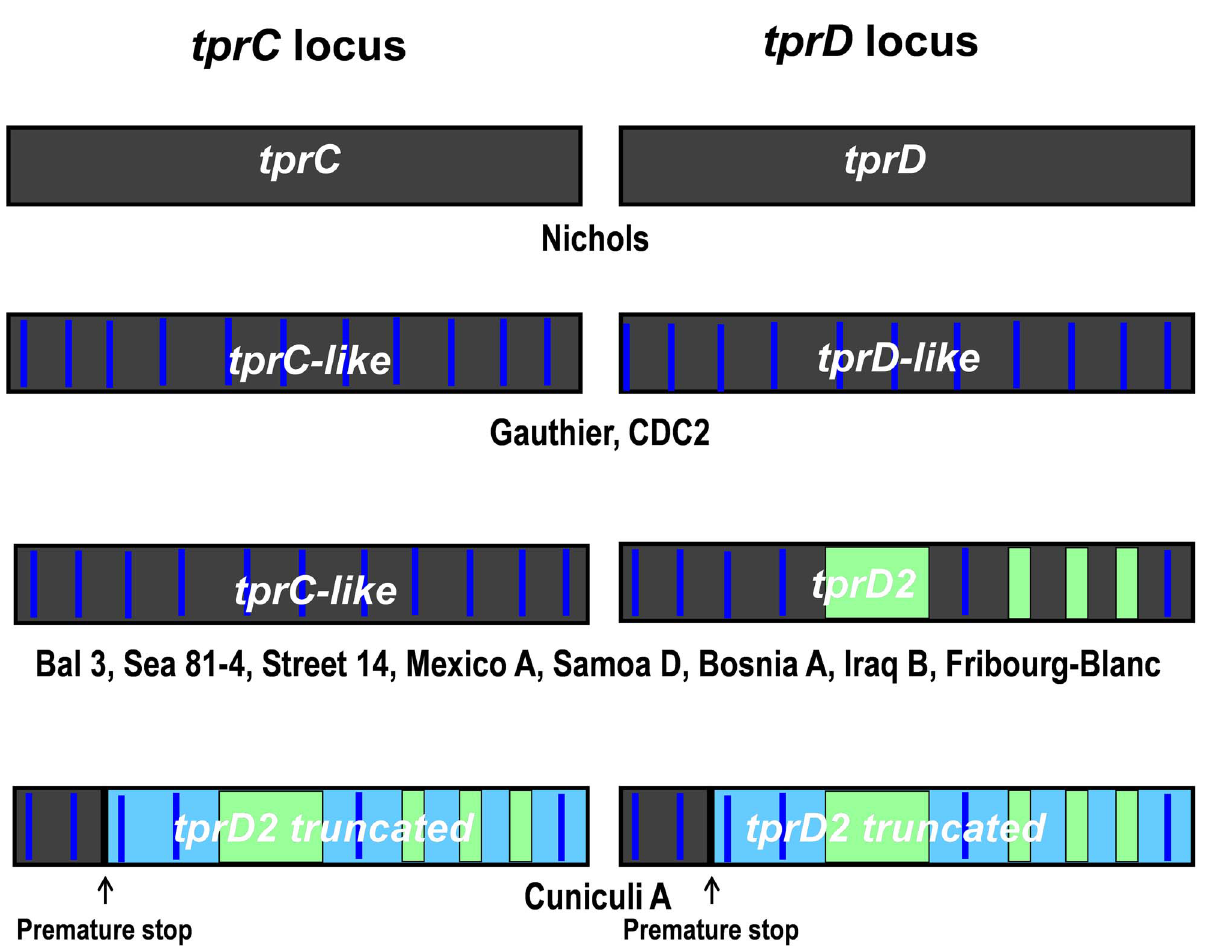
Figure 2. Allelic variants at the tprC and tprD loci. Four allelic combinations are found at these two loci: 1) identical tprC and tprD , 2) tprC -like and tprD -like, 3) tprC -like and tprD2 , and 4) tprD2 truncated and tprD2 truncated. Same background color indicates sequence identity. Vertical blue lines indicate discrete variable regions (DVRs), which contain mutations in great majority of non-synonymous character. Green color indicates unique tprD2 signatures. Light blue background indicates predicted untranslated regions of the ORFs in the tprD2 alleles due to a single nucleotide insertion, frameshifting and a premature stop.